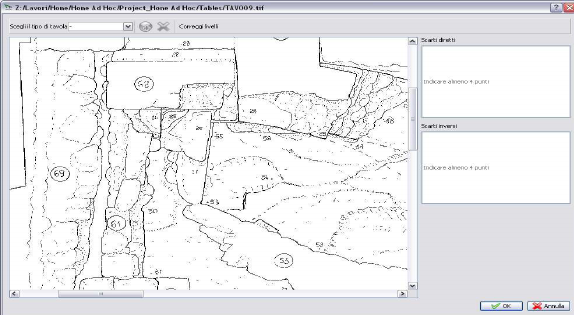
Figure 5. Handmade drawing georeferencing